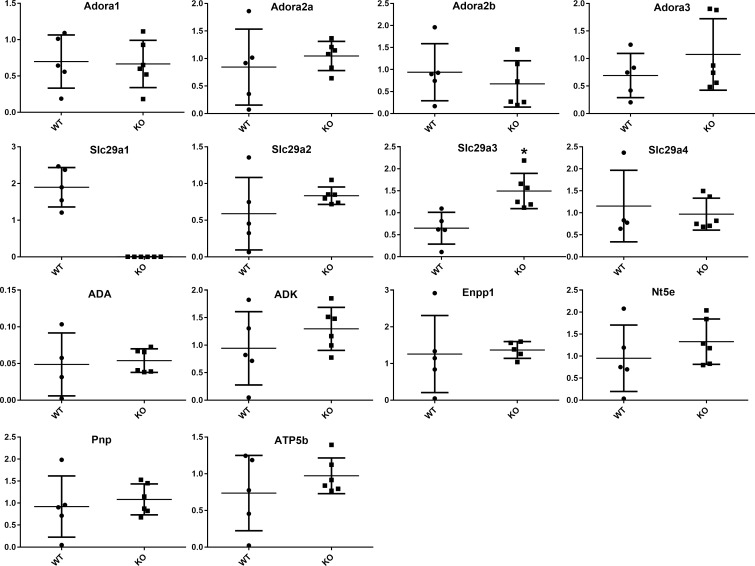
Gene expression in wildtype and Slc29a1-null mice: qPCR was employed, using the primer sets shown in S1 Table, to assess the relative expression of the equilibrative nucleoside transporters, Slc29a1, Slc29a2, Slc29a3, and Slc29a4, the adenosine receptors, Adora1, Adora2a, Adora2b, and Adora3, and enzymes involved in purine metabolism, ADA, Nt5e, ADK, Pnp, Enpp1, and ATP5b.Gene expression (mean ± SEM) is shown as relative to the geometric mean of the reference genes UBC, eIF4a2, and ActB. * Significant difference between wild-type (N = 5) and Slc29a1-null (N = 8) mice (Student’s t-test for unpaired samples, two-tailed, P<0.05).